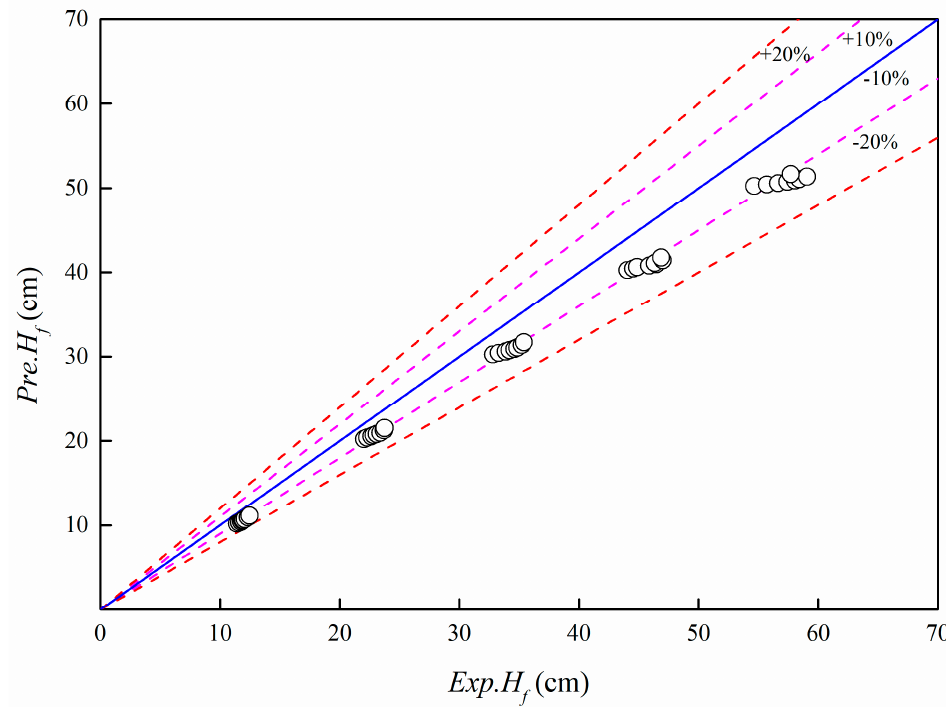
Figure 9. Error analysis of the predicting model of bed expansion of the micron-sized particle.